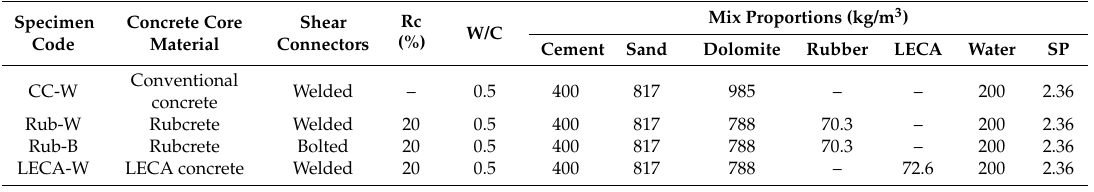
Figure 1. Beam geometry and shear connector details. Table 1. Properties of the test specimens and concrete mix proportions.